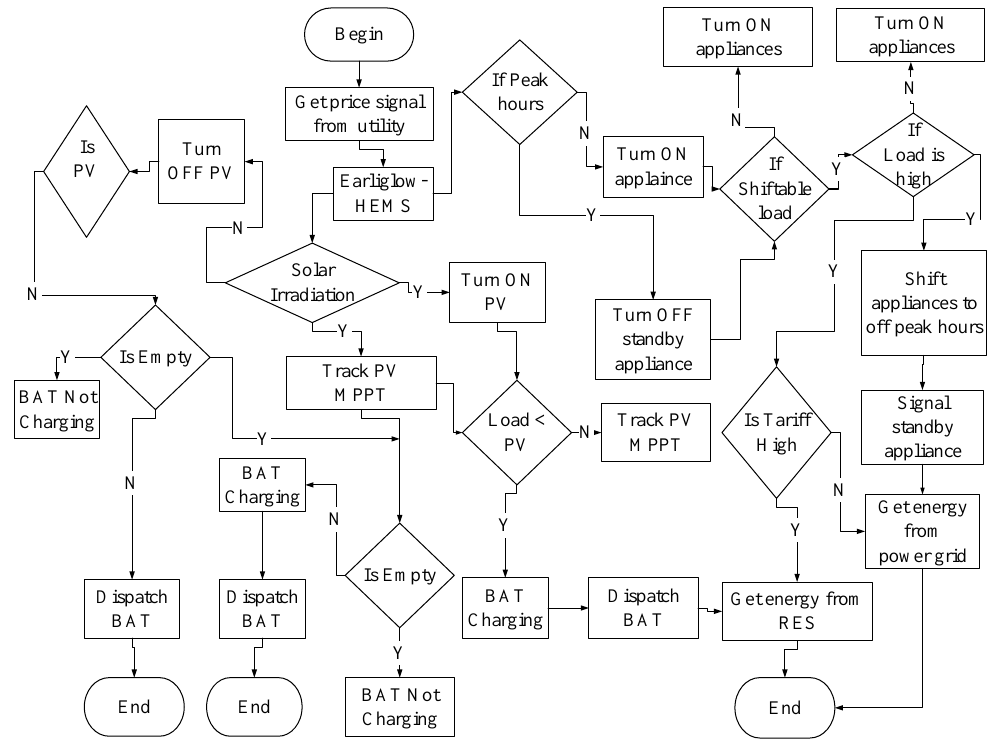
Figure 2. Proposed Earliglow based home energy management system (HEMS)